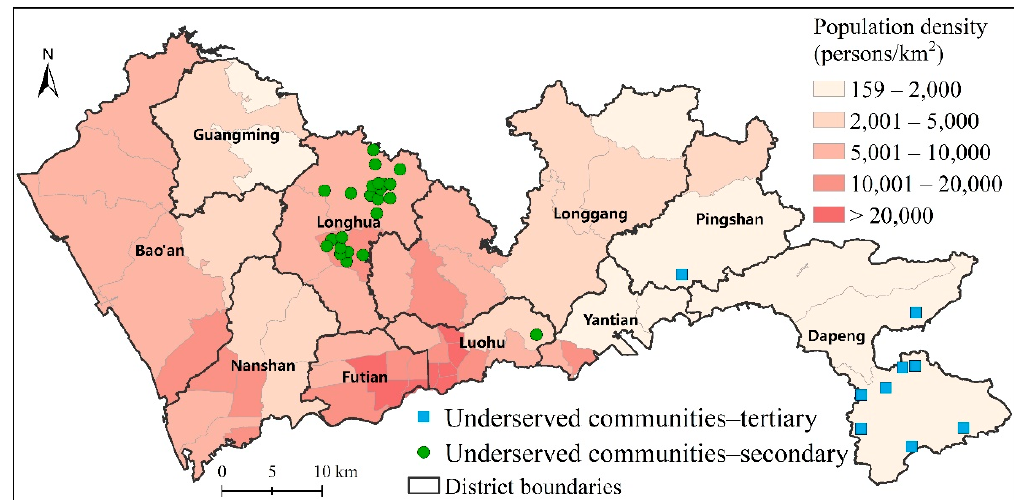
Figure 3. Underserved demand nodes of existing healthcare facilities.